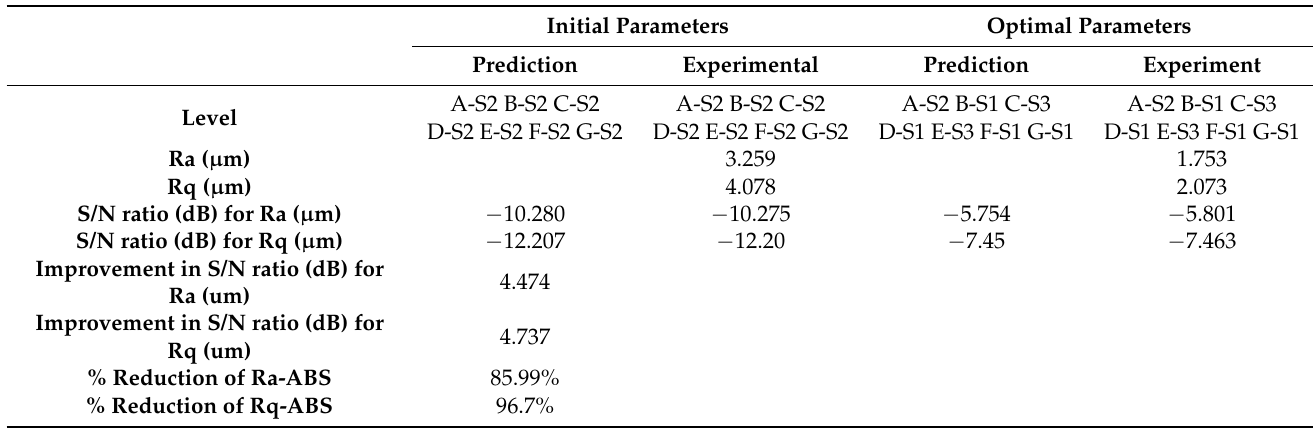
Table A5. The Confirmation test outcomes for Ra-ABS and Rq-ABS polymer.